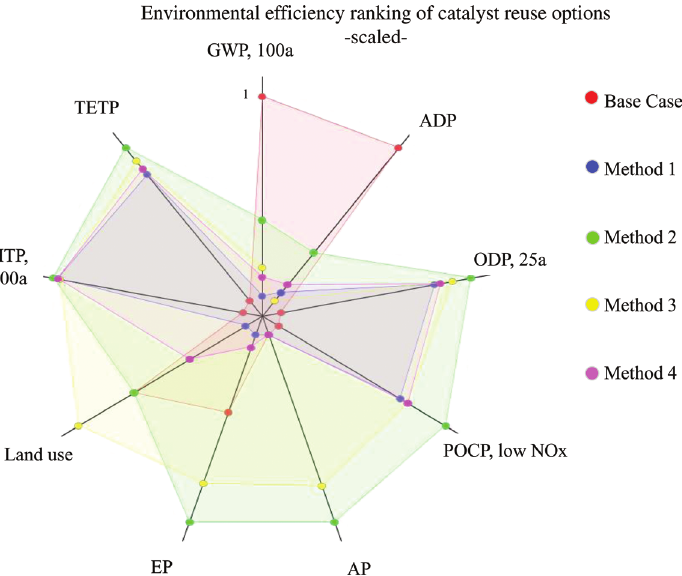
Figure 3 Multi-criteria outranking of base case versus Methods 1–4 concerning environmental efficiency, taking into account several life cycle impact assessment (LCIA) categories.